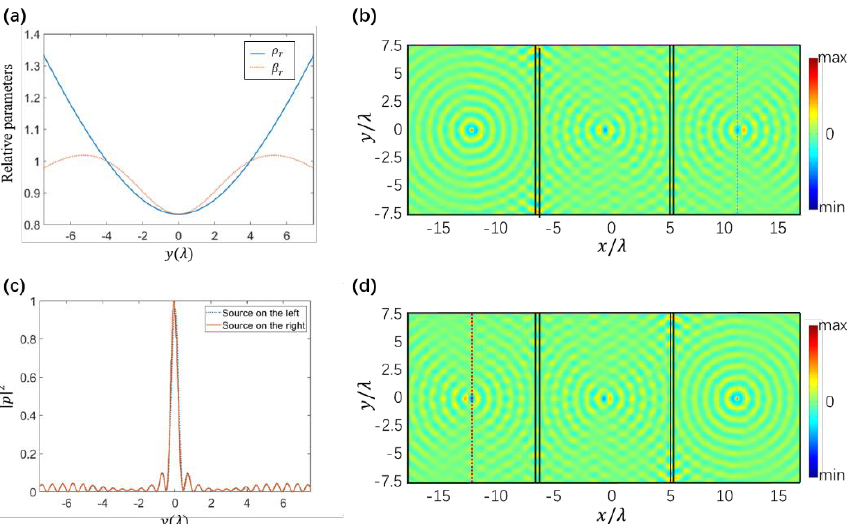
Figure 5. ( a ) The relative material parameters ρ r and β r versus y-coordinate. ( b , d ) the acoustic field patterned with point source placed at ( − 12r, 0) and (12r, 0), respectively. ( c ) The acoustic field intensity amplitudes at the imaging planes. The red and black curves represent the intensity fields in the focus planes indicated by the red dashed lines in ( b , d ), respectively.